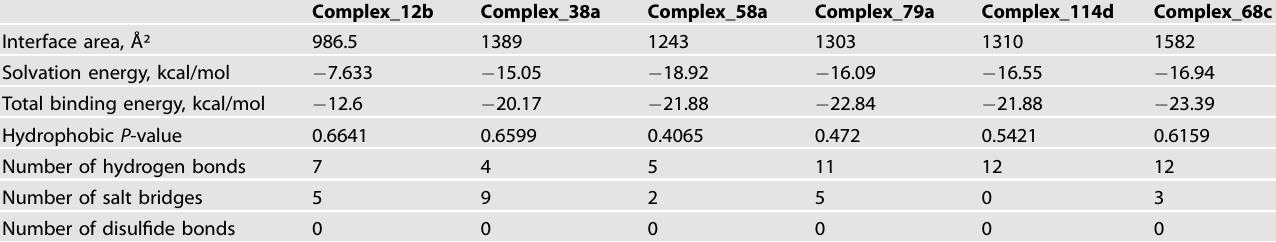
All complexes exhibit a low total binding energy, thus demonstrating an energetically favorable binding between SNAP29 and α -Syn.